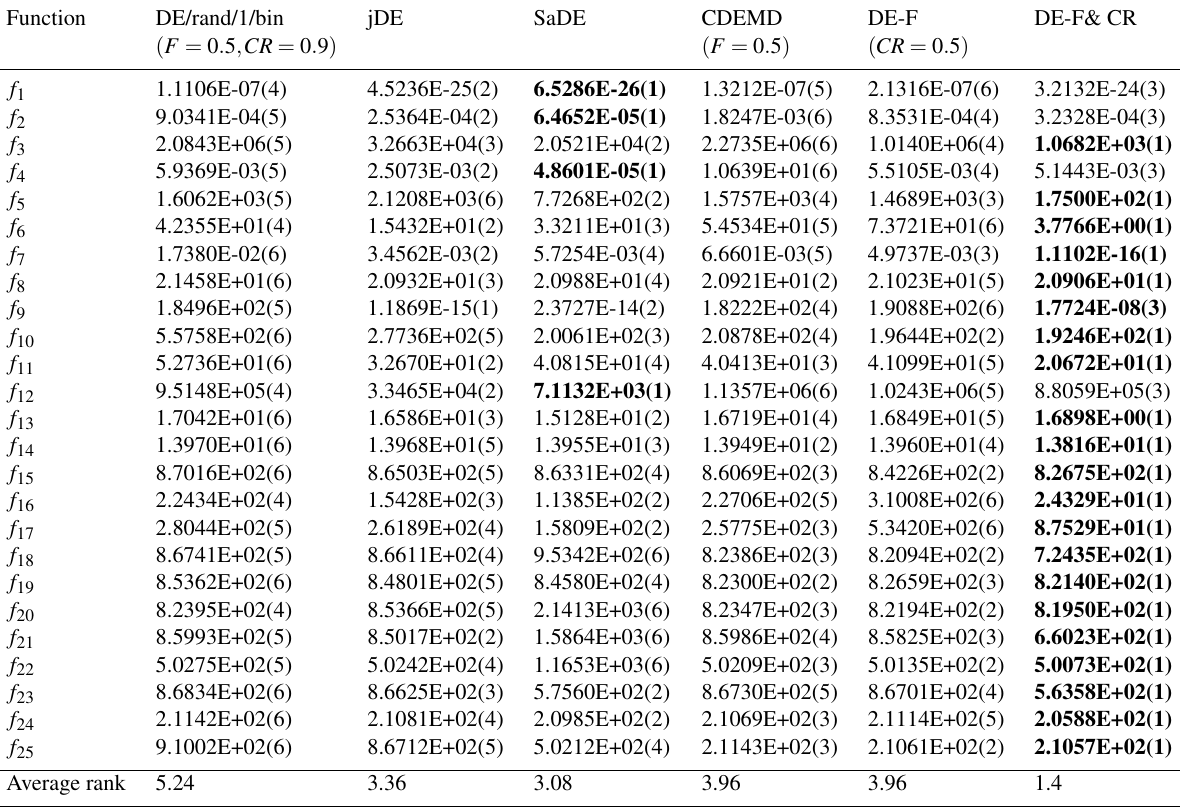
Table 4. Mean and ranks of the best error values for D